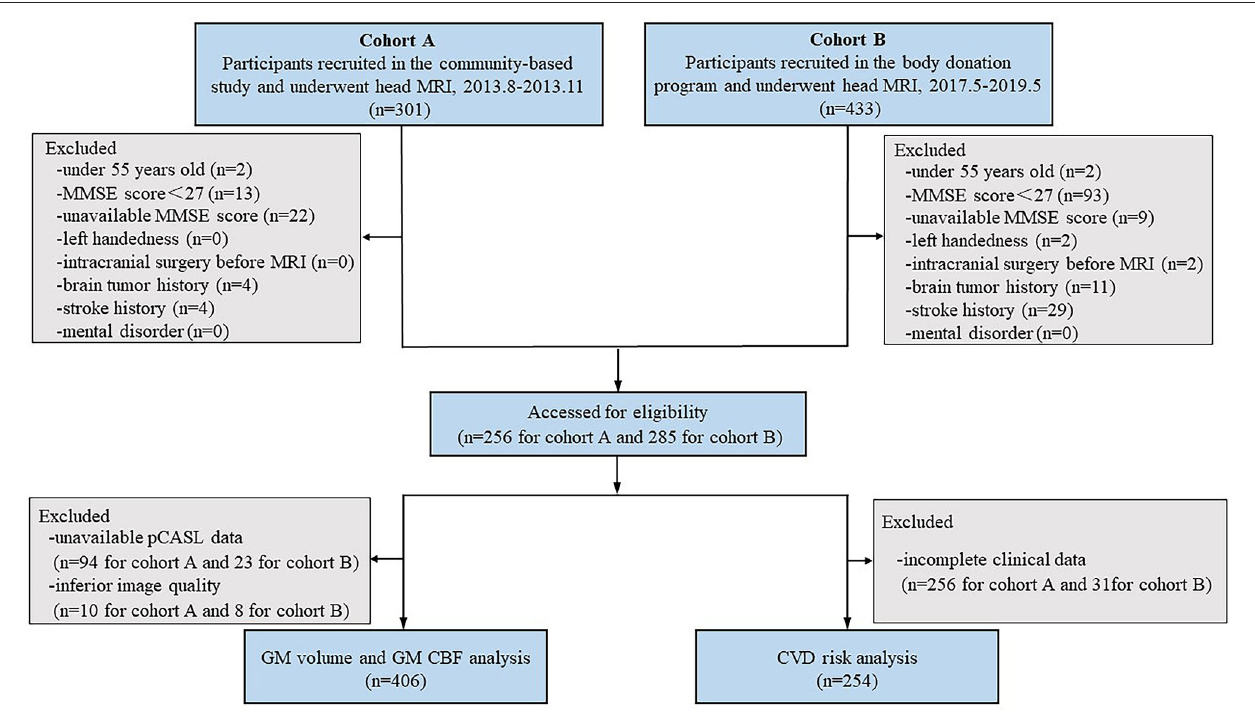
FIGURE 1 | Study flowchart shows the recruitment of study participants. MMSE, Mini-Mental State Exam; pCASL, pseudo-continuous arterial spin